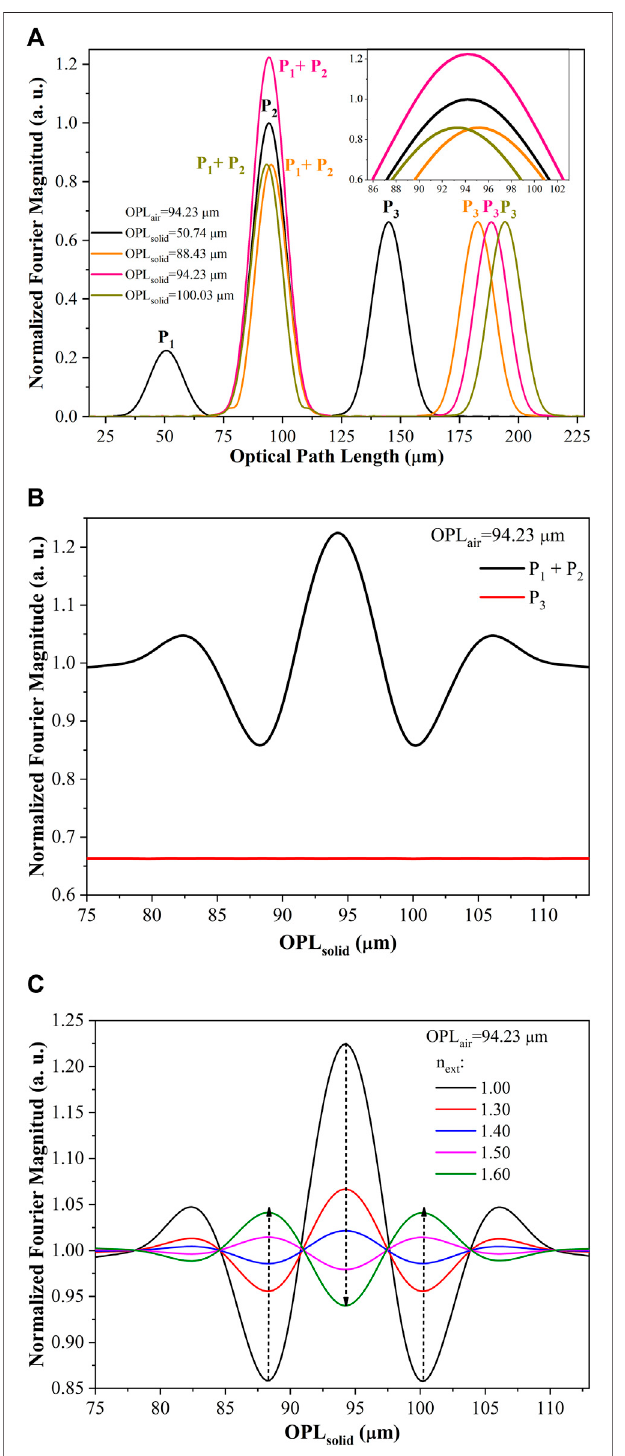
FIGURE 3 | (A) Experimental spectra of the optical re fl ectance and (B) the corresponding Fourier transform. (C) Changes in the magnitude of the Fourier spectra peak when the i-HFFPI was immersed in different Cargille immersed in the liquid samples. The amplitude of the peaks in the spectra increases as the value of n ext increases but as was expected,